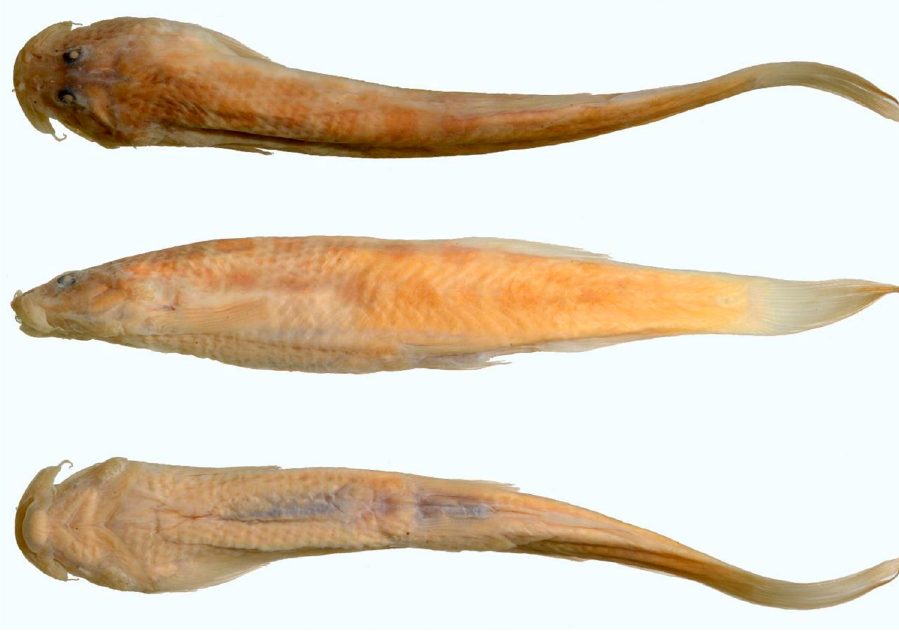
FIGURE 23 | Scleronema operculatum , paratype (FMNH 58520; 58.6 mm SL), Brazil, Rio Grande do Sul, Cacequi, rio Cacequi, tributary to rio Santa Maria, rio Ibicuí basin, lower rio Uruguay. Photograph taken by Sandra Raredon.